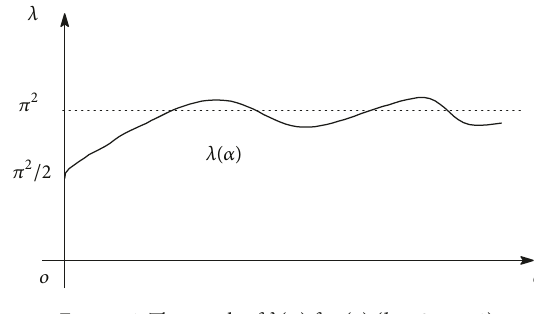
Figure 1: The graph of 𝜆(𝛼) for (5) ( 𝑘 = 0, 𝑛 = 1 ). For (5) with (2)–(3), the asymptotic behavior of 𝜆(𝛼) as 𝛼 󳨀→ 0 is as follows. For a solution pair (𝜆(𝛼), 𝑢 ) satisfying 𝛼 ‖𝑢 ‖ = 𝛼 , put V (𝑡) fl 𝑢 (𝑡)/𝛼 and let 𝛼 󳨀→ 0 . Then we 𝛼 ∞ 𝛼 𝛼 easily obtain the function V 0 ∈ 𝐶 2 (𝐼) which satisfies − V 󸀠󸀠 0 (𝑡) = 2𝜆(0) V (𝑡) , V (𝑡) > 0 for 𝑡 ∈ 𝐼 with V (0) = V (1) = 0 . 0 0 0 0 This implies 𝜆(0) = 𝜋 2 /2 . By this fact and Theorem 1, the bifurcation curve 𝜆(𝛼) starts from 𝜋 2 /2 and tends to 𝜋 2 with oscillation and intersects the line 𝜆 = 𝜋 2 infinitely many times for 𝛼 ≫ 1 .